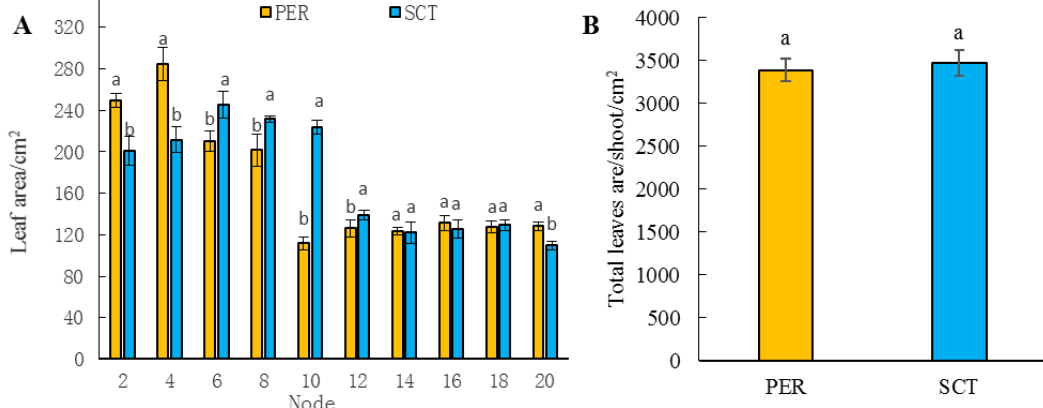
Figure 6. The leaf area at different nodes ( A ) and the total leaf area ( B ) under PER (pergola) and SCT (single-curtain training system) at veraison. Data are means ± SD from three independent replicates. Different letters indicate a significant difference at p < 0.05 as determined by Duncan’s multiple range test.